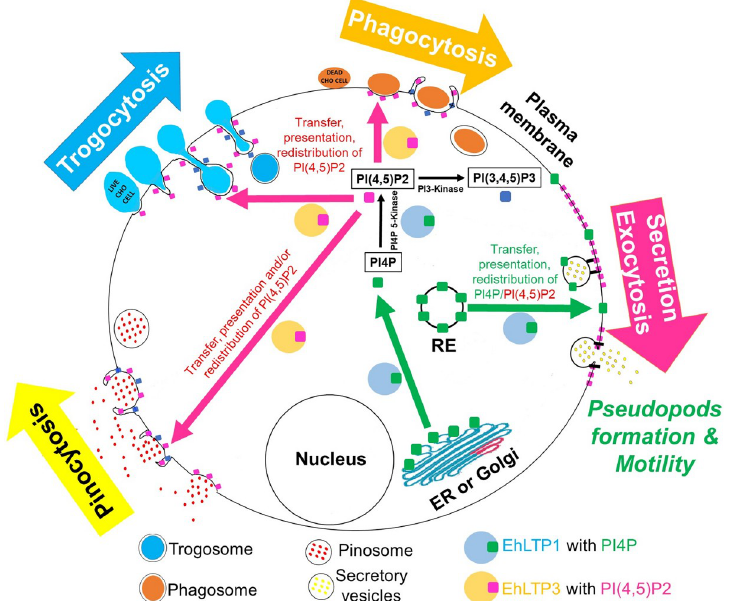
Fig 8. Schematic diagram represents potential function of EhLTP1 and EhLTP3 in E . histolytica during endo- (trogocytosis, phagocytosis and pinocytosis) and exocytosis. Both of EhLTP1 and EhLTP3 can transport PI(4)P to plasma membrane (PM) from endoplasmic reticulum (ER) or other cell organelles (for instances, RE, recycling endosome) and modulate the local synthesis of PIPs. However, EhLTP3 regulates exclusively the receptor-mediated endocytosis (trogocytosis, phagocytosis and pinocytosis) process via various mode of action of PITPs as proposed in the discussion. In contrast, EhLTP1 can regulates both receptor-mediated endocytosis (trogo- and phagocytosis) and exocytosis processes. It can facilitates the reorganization of membrane PtdIns(4,5)P 2 followed by priming and docking of the exocytic vesicle complex, hence the exocytosis.